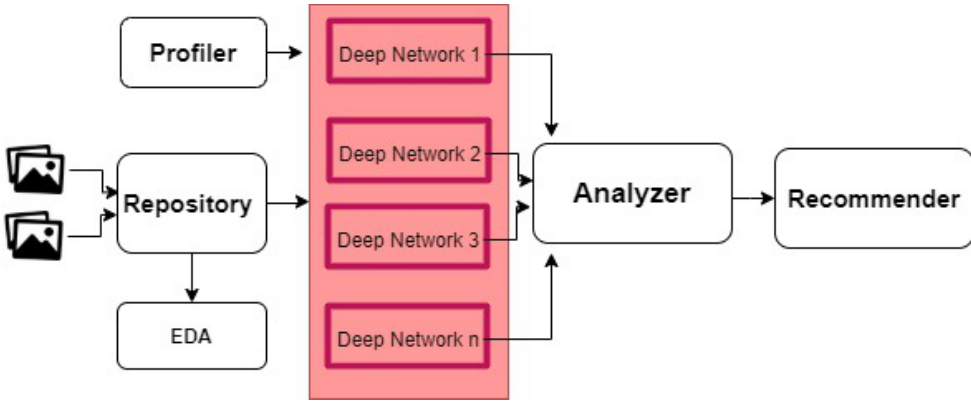
Figure 3. Main architecture of the smart-deep